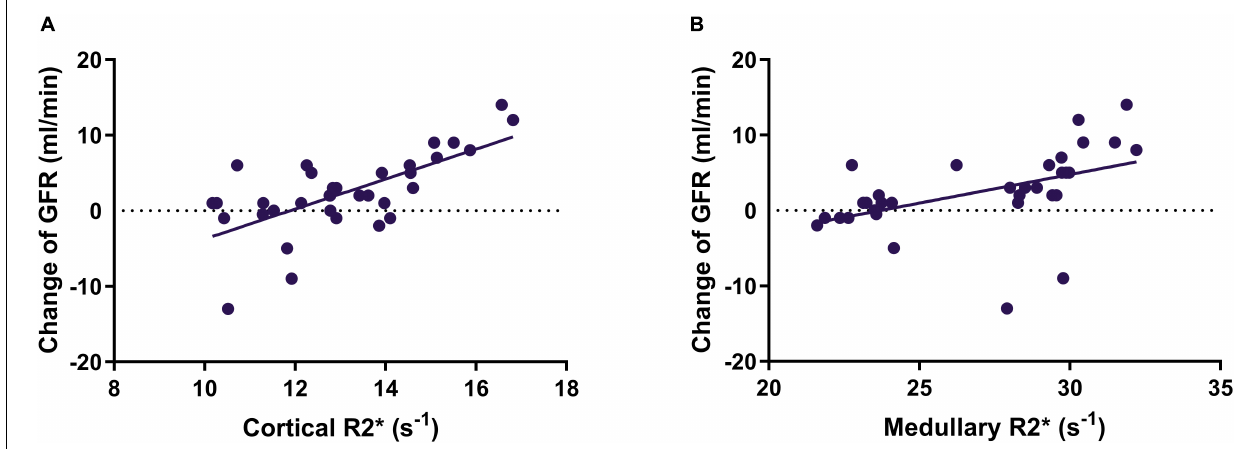
FIGURE 3 | The correlation between cortical R2* (A) and medullary R2* (B) and change of SRF of the stented kidney. SRF, split renal function; GFR, glomerular filtration rate.